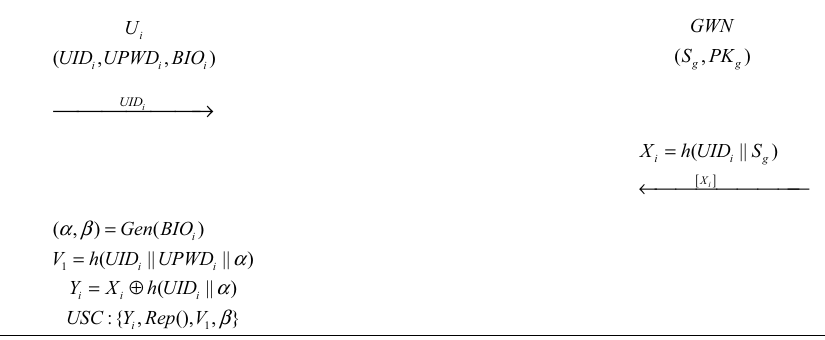
Algorithm 1 : User-gateway registration